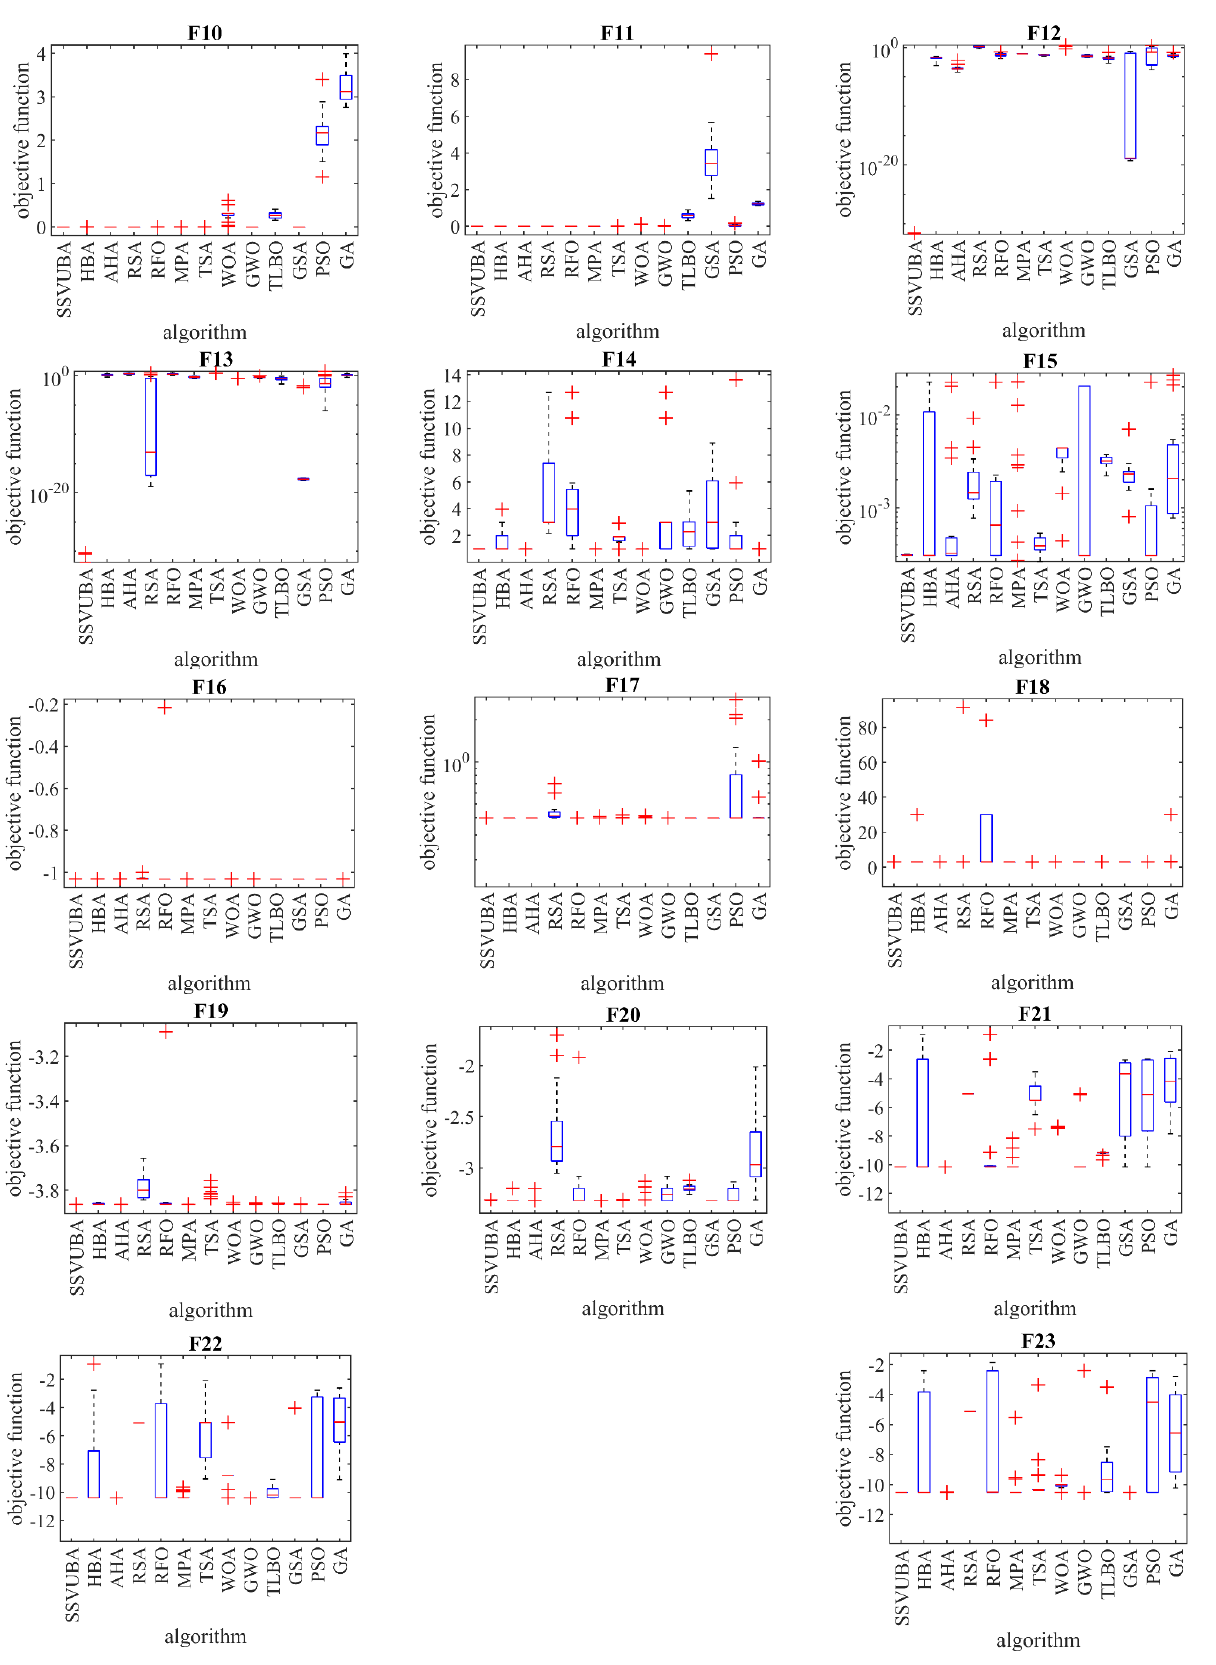
Figure 3. Boxplot displaying SSVUBA performance against compared algorithms in the F1 to F23 optimization.